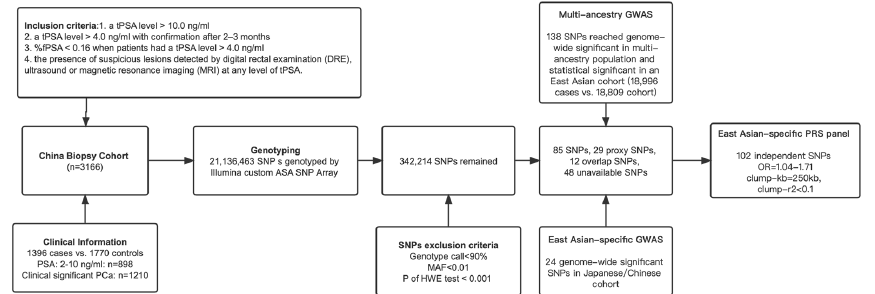
Figure 1. Flow diagram presenting the participant’s enrollment to the study and selection of SNPs for polygenic risk score. Abbreviation: PCa, prostate cancer; GWAS, genome-wide significant study; SNP, single-nucleotide polymorphism; ASA, Asian screening array; MAF, minor allele frequency; HWE, Hardy-Weinberg Equilibrium; PRS, polygenic risk score; tPSA, total-prostate-specific antigen; %fPSA, free PSA/tPSA; DRE, digital rectal examination; MRI, magnetic resonance